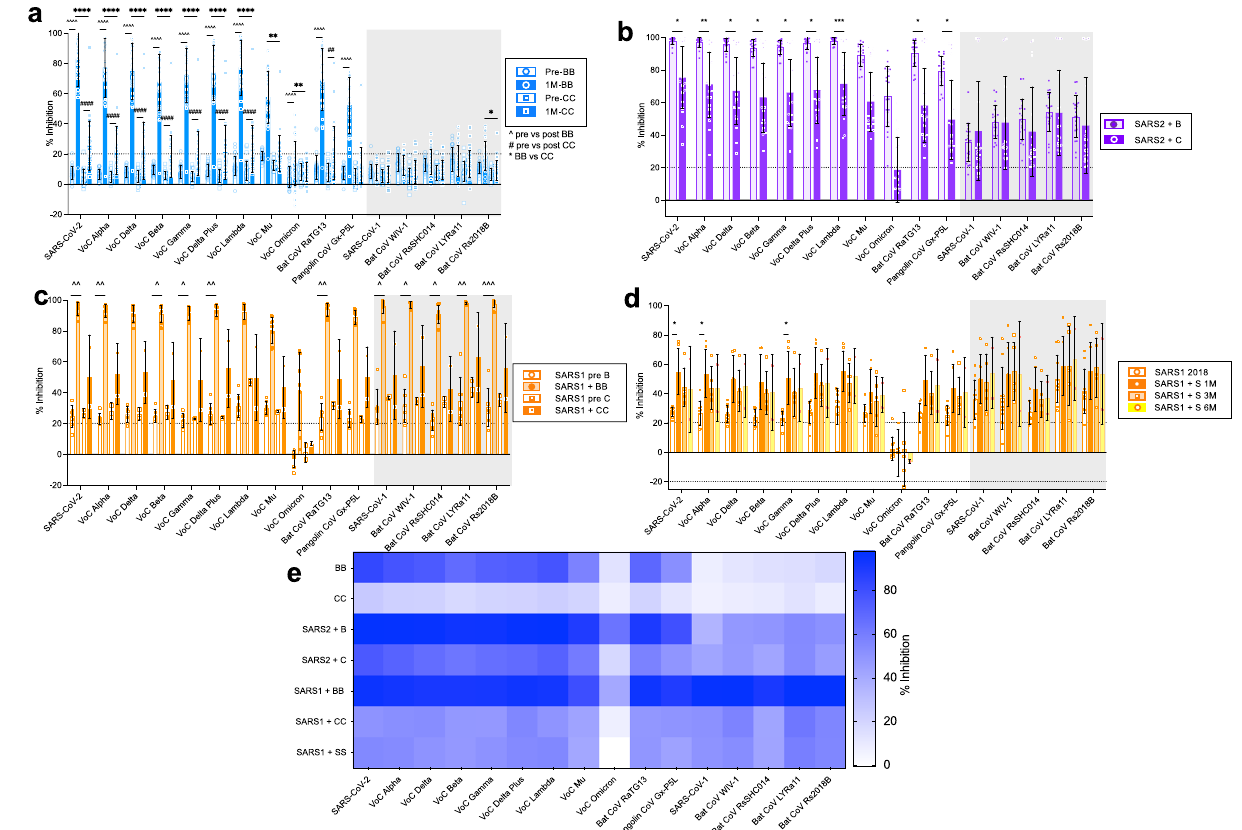
Fig. 2 | Prior priming by infection accentuates mRNA vaccine antibody pro fi le to sarbecovirus RBD. The % antibody inhibition of ACE2 binding to RBD was determinedfor a uninfectedsubjectspreand1monthpost2dosevaccinationwith BNTb162b2 (B) or Coronavac (C) ( n =30 subjects). b COVID-19 infected 1 month post 1 dose vaccination with BNT162b2 (SARS2+B) or Coronavac (SARS2+C) ( n =20 subjects, prior infection 346+/ − 105 days before vaccination). c Hong Kong (HK) SARS-CoV-1 infected patients (SARS1) 1 month post 2 dose vaccination with BNT162b2 (SARS1+B, n =7 subjects) or Coronavac (SARS1+C, n =2 subjects). d Guangzhou (GZ) SARS-CoV-1 infected patients from 2018 ( n =10 subjects) and post 2 dose vaccination with Sinopharm (SARS1+S) at 1 to 6 months post